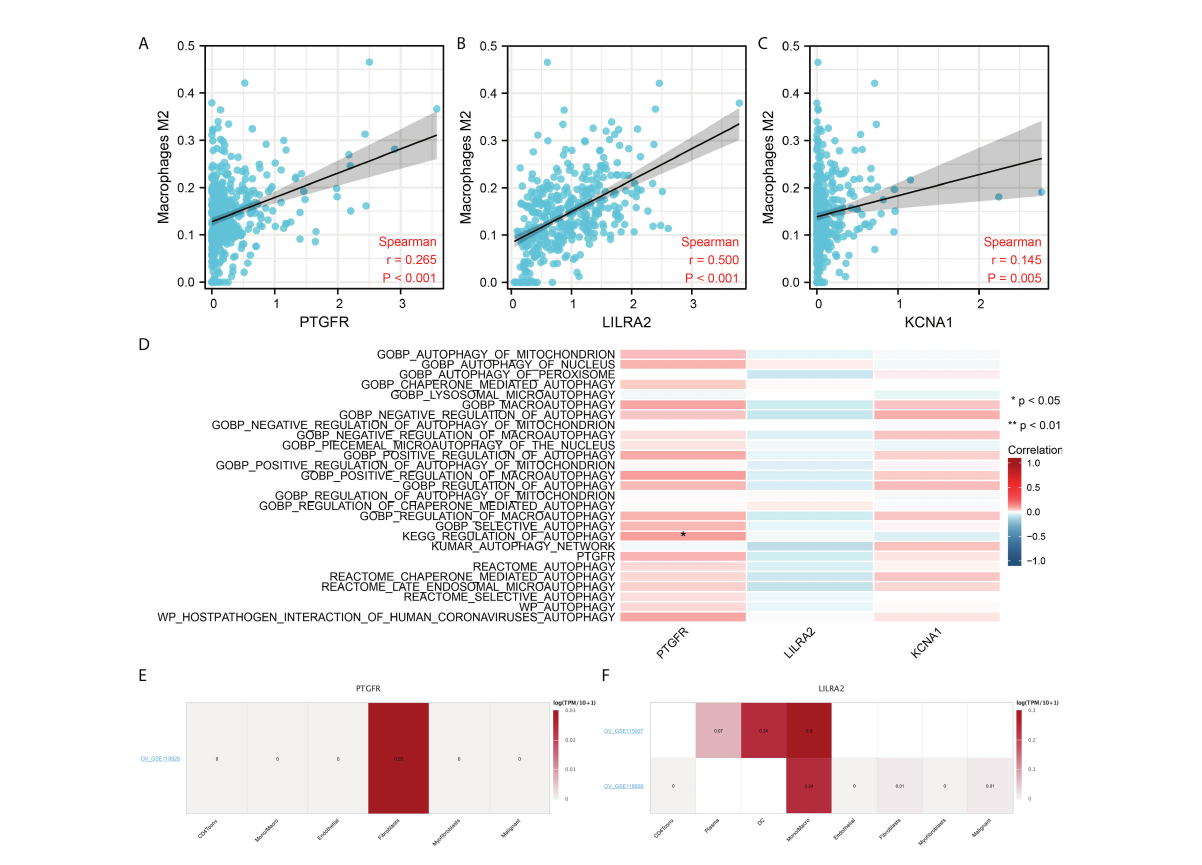
FIGURE 8 Further exploration of the PTGFR, LILRA2 and KCNA1. (A – C) PTGFR, LILRA2 and KCNA1 were signi fi cantly positively correlated with the M2 macrophages in fi ltration; (D) The association between model genes and autophage activity; (E) PTGFR was mainly expressed in the fi broblasts; (F) LILRA2 was mainly expressed in Mono/Macro. *P <